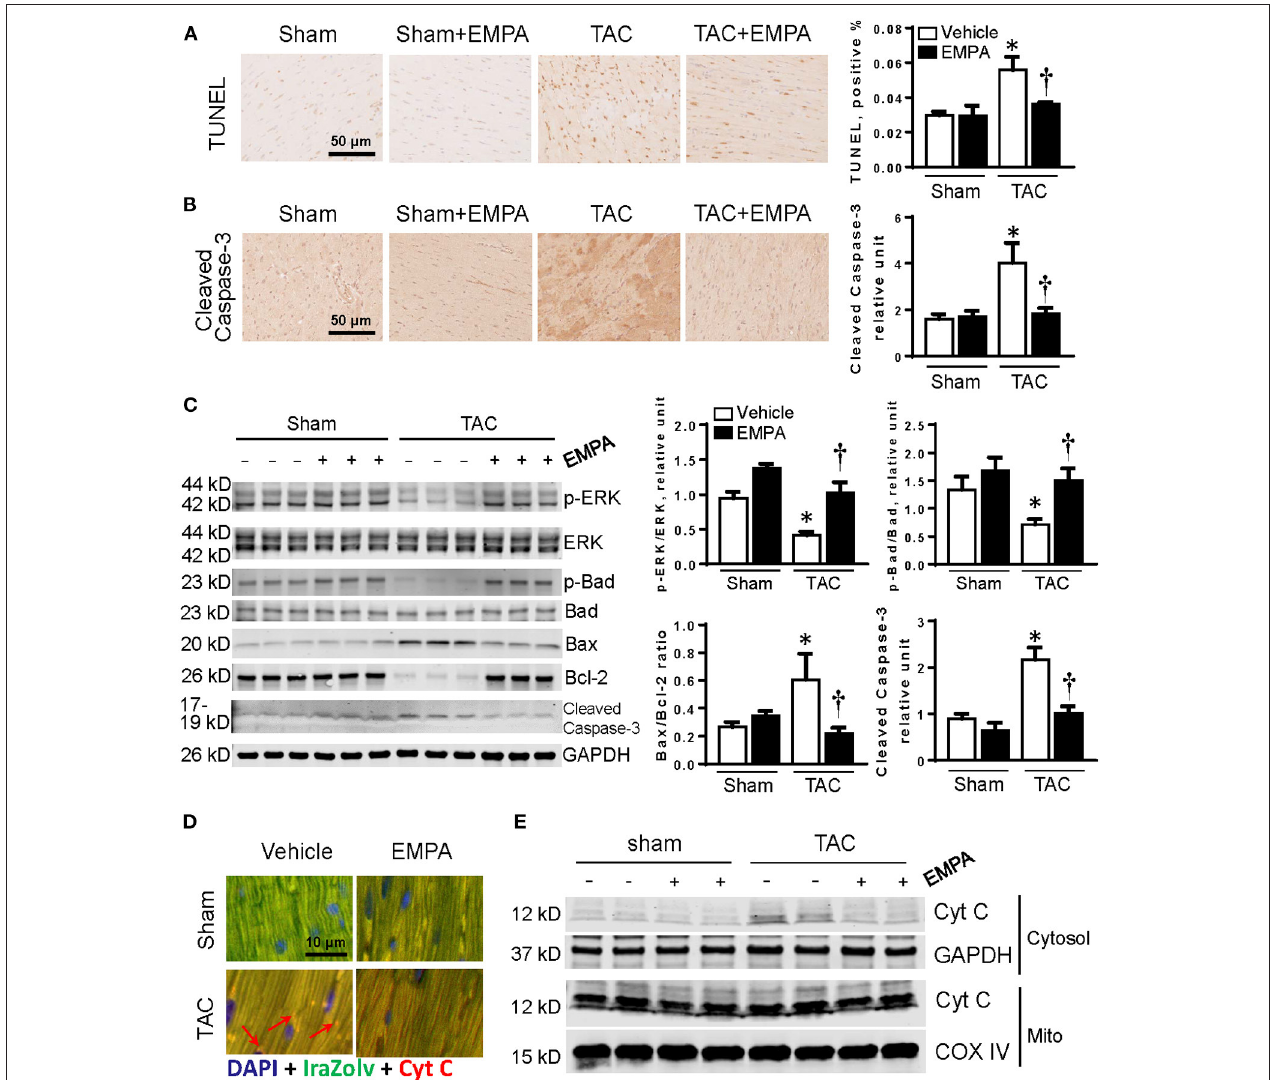
FIGURE 4 | EMPA treatment attenuated apoptosis in TAC-induced HF. (A) TUNEL staining of heart sections in sham, sham + EMPA, TAC and TAC + EMPA groups. (B) Immunohistochemistry results of cleaved caspase-3 in different groups. (C) Left, representative blots of proteins related to cellular survival and apoptotic pathways and Right, quantitative results. (D,E) Increased Cyt C released from mitochondria into cytoplasm after TAC is attenuated by EMPA treatment. Results are expressed as mean ± SEM, n = 5–7, * p < 0.05 vs. corresponding sham group, † p < 0.05 vs. corresponding TAC vehicle group. One-way ANOVA and Tukey post hoc test. EMPA, empagliflozin; SEM, standard error of the mean; TAC, transverse aortic constriction; ERK, extracellular signal-regulated kinase; Cyt C, cytochrome C; COX IV, cytochrome c oxidase, complex IV in the mitochondrial respiratory chain; DAPI, 4’,6-diamidino-2-phenylindole; GAPDH, glyceraldehyde 3-phosphate dehydrogenase.